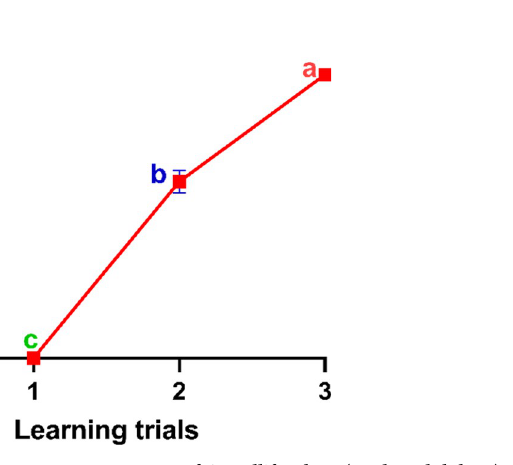
Fig 1. Proboscis extension response percentage of A . mellifera bees (12-day adult bees) of in odor response and sucrose reward. PER (%) explicit the significantly higher learning response 3 rd conditioning trial as compared to 2 nd and 1 st trials.